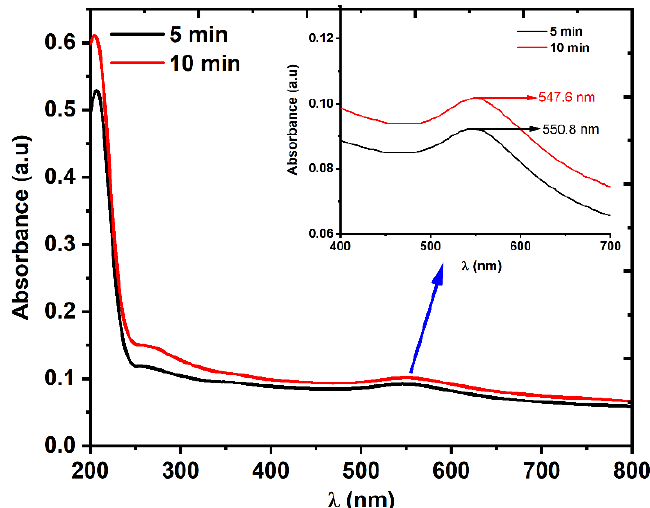
Figure 5. The linear absorption spectra of two Au NP samples that were prepared using 5 and 10 min laser ablation times. The LSPR peaks in the visible region are shown in the inset. laser ablation times. The LSPR peaks in the visible region are shown in the